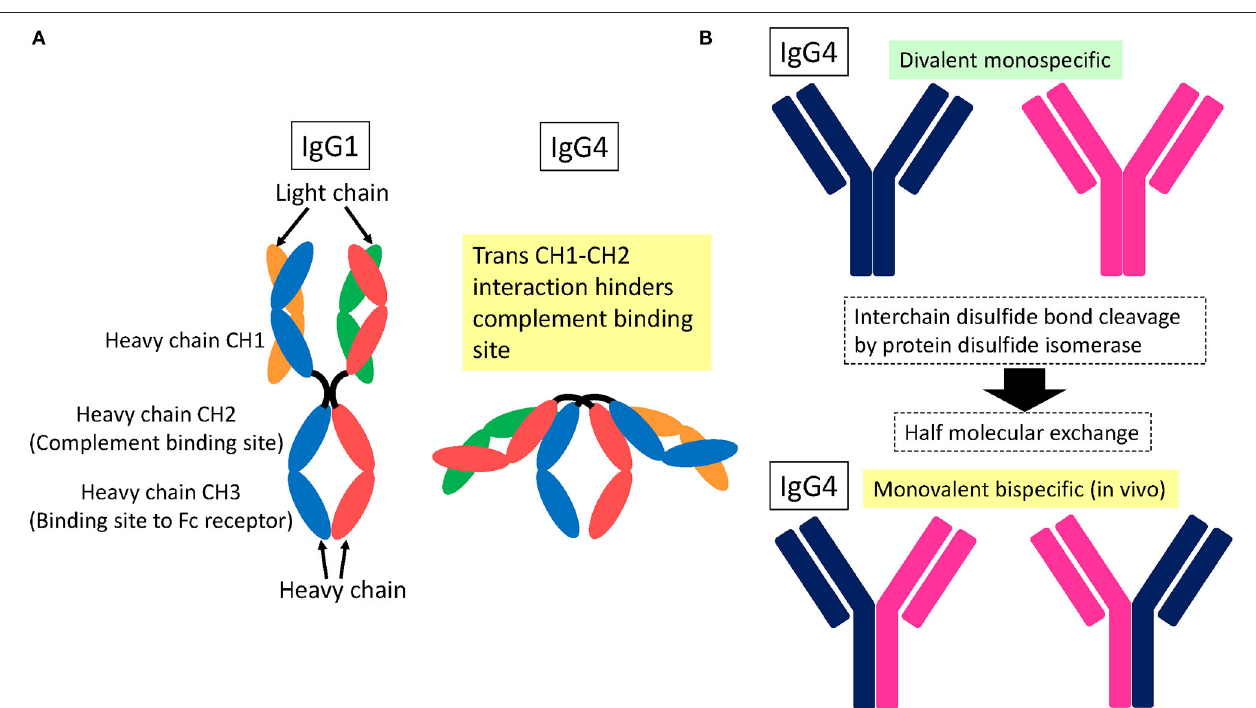
FIGURE 2 | Schematic structure of IgG4. (A) Trans heavy-chain CH1–CH2 domain interaction hinders the CH2 domain within a compact structure (12). As a result, complement proteins cannot access the CH2 domain for fixation. (B) IgG4 is subjected to interchain disulfide bond cleavage by protein disulfide isomerase expressed on immunocytes and endothelial cells, which leads to half-molecule exchange ( 12). Consequently, in vivo IgG4 exists in a monovalent and bispecific form, which prevents IgG4 from internalizing target surface antigens.